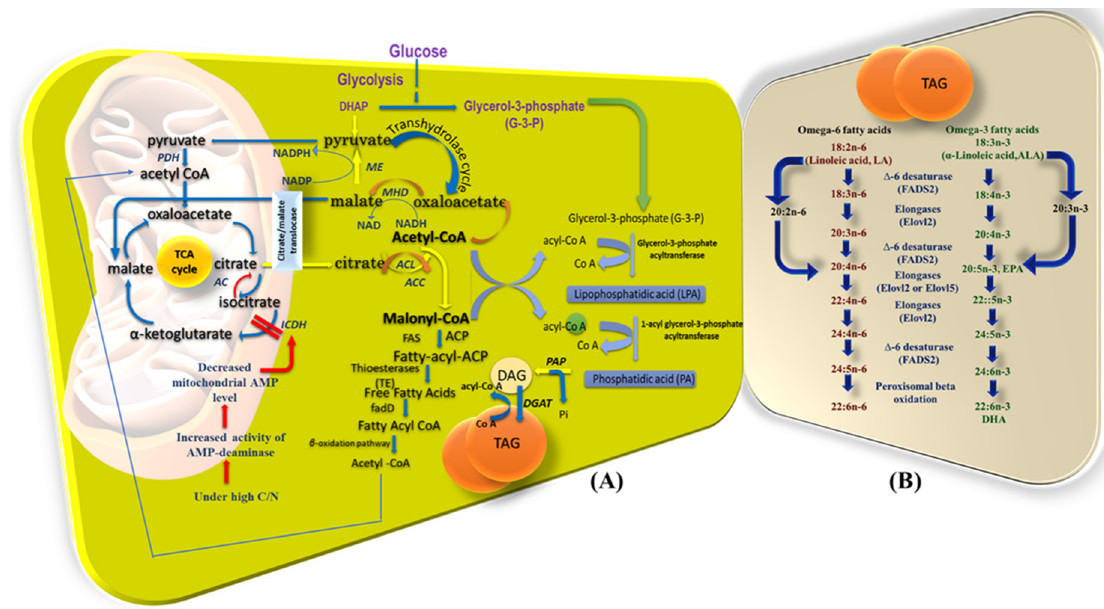
Figure 3. ( A ) De-novo fatty acid synthesis in oleaginous microorganisms (adapted from [13,16,18,221,243,244]), and enzymes involved in lipid accumulation. AC, aconitase; ACC, acetyl-CoA carboxylase; ACL, ATP-citrate lyase; ACP, acyl carrier protein; FAS, fatty acid synthetase; ICDH,